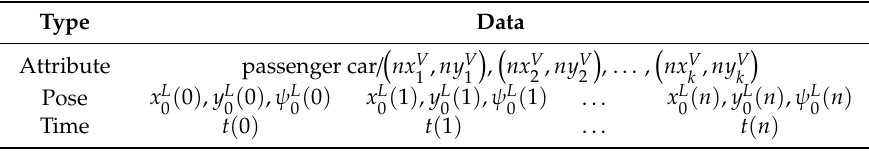
Table 4. Example of a vehicle as the time-varying pose